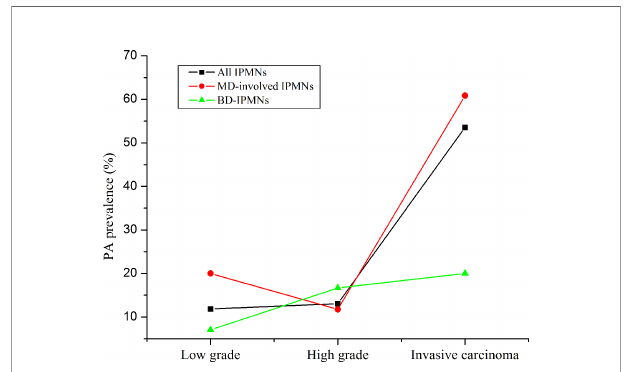
FIGURE 1 | The prevalence of pancreatic atrophy in all intraductal papillary mucinous neoplasms (IPMNs), MD-involved IPMN, and BD-IPMNs. The p- values for trends were less than 0.01 and was 0.21. “ Low ” means low and